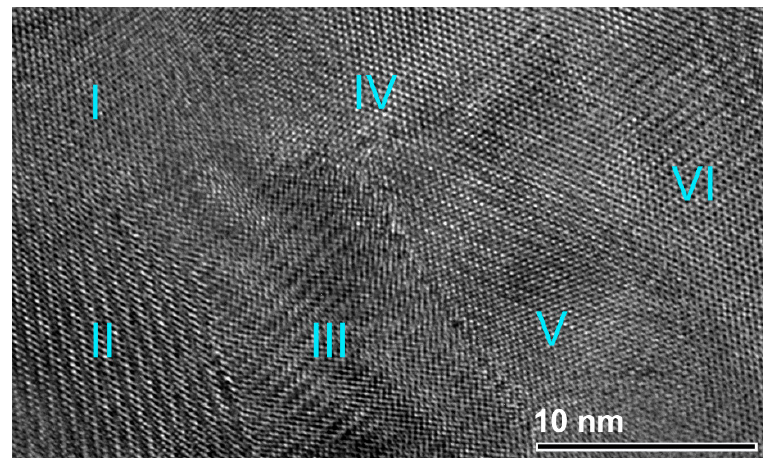
Figure 7. An atomic-resolution FE-TEM of the planer view for the as-consolidated fcc-ZrN metastable phase that was obtained after 259 ks of RBM and then SPS. The image, which presents six (I to VI) nanograins, indicates a highly-dense structure, and the existence of stacking faults and twin boundaries.